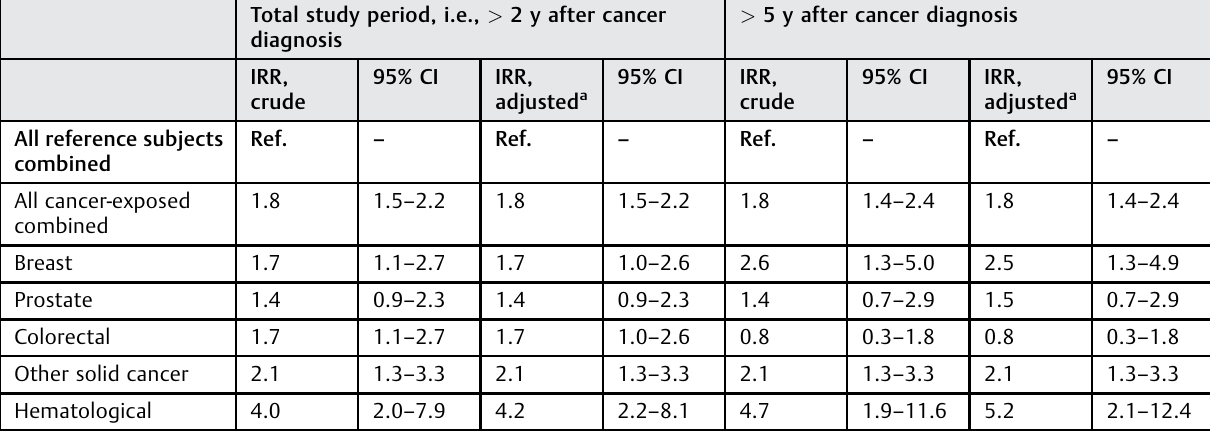
Table 3 Crude and adjusted IRRs of VTE in cancer-exposed subjects by increasing time since cancer diagnosis Total study period, i.e., > 2 y after cancer